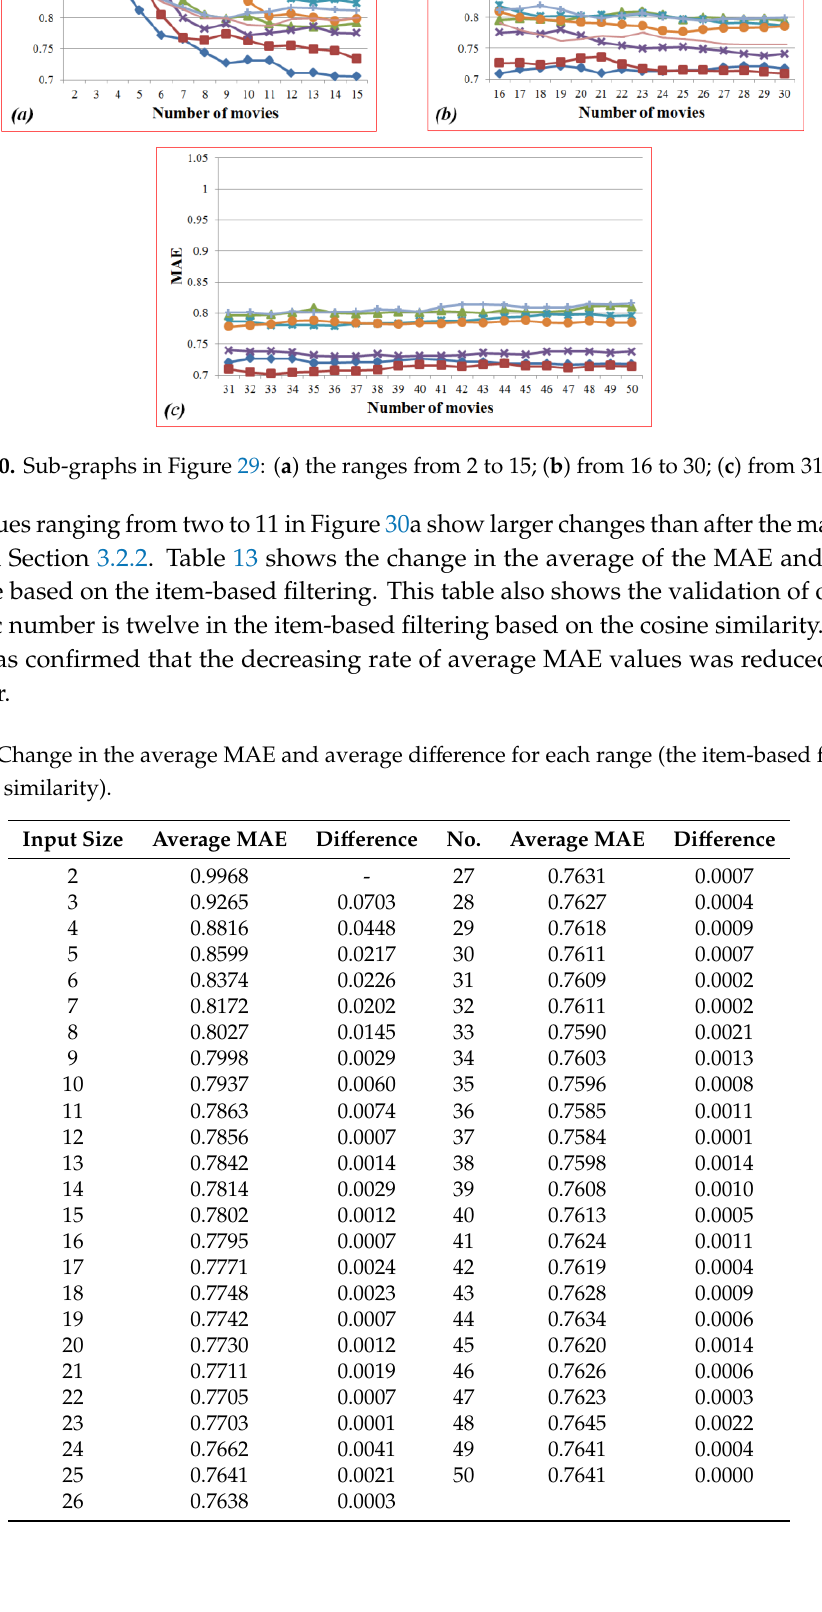
Figure 29. MAE values for the different numbers of ratings based on the cosine similarity in the item- based filtering.